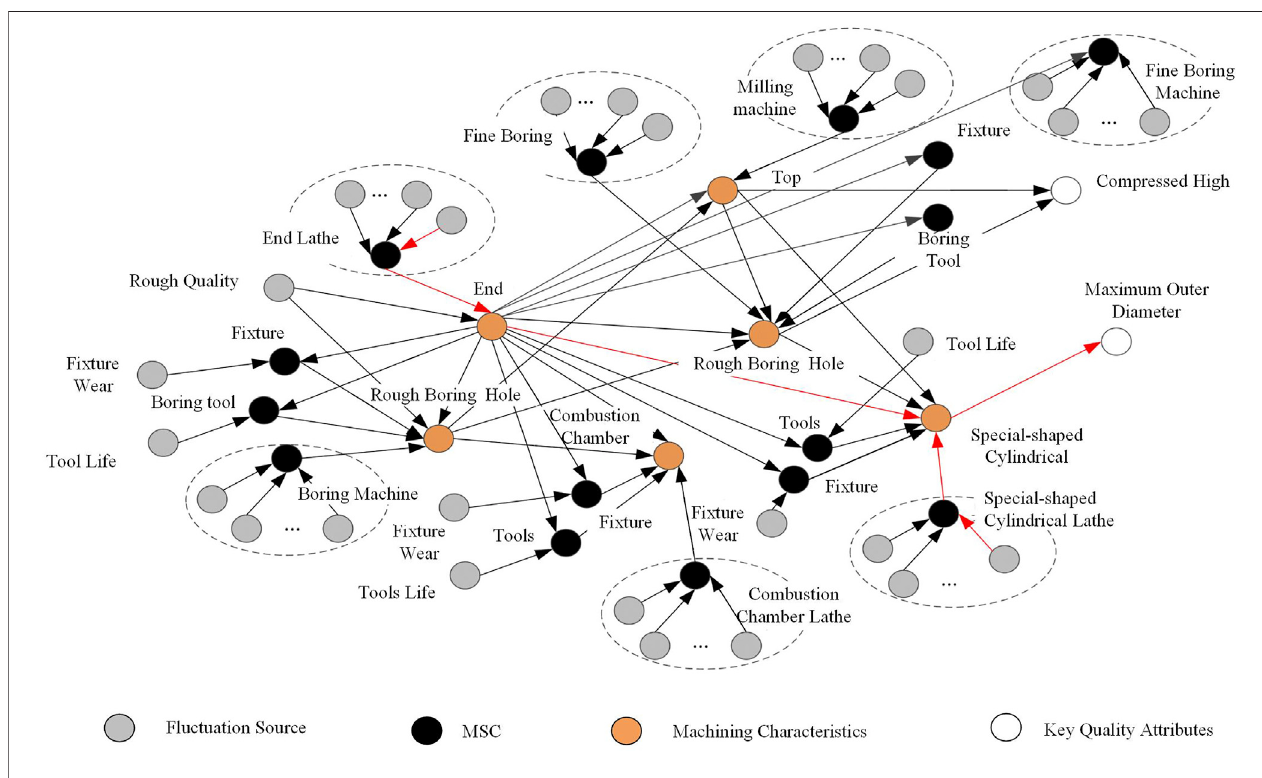
FIGURE 13 | Piston Production Line error propagation network.